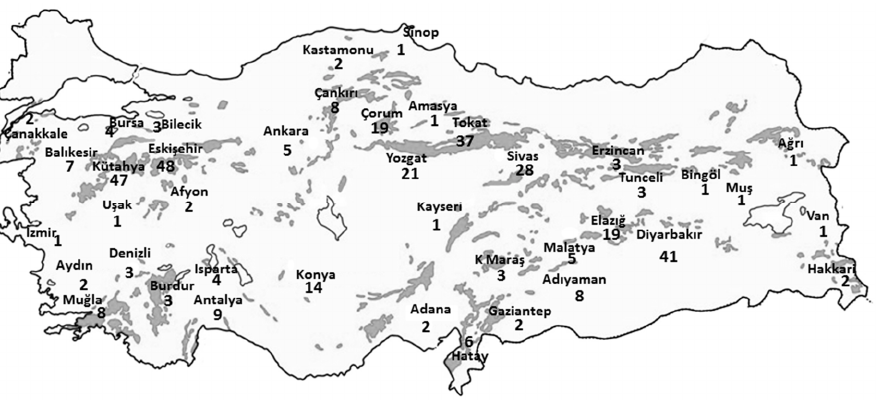
Figure 1. Map of Turkey showing the distribution of villages where asbestos exposure was definite,